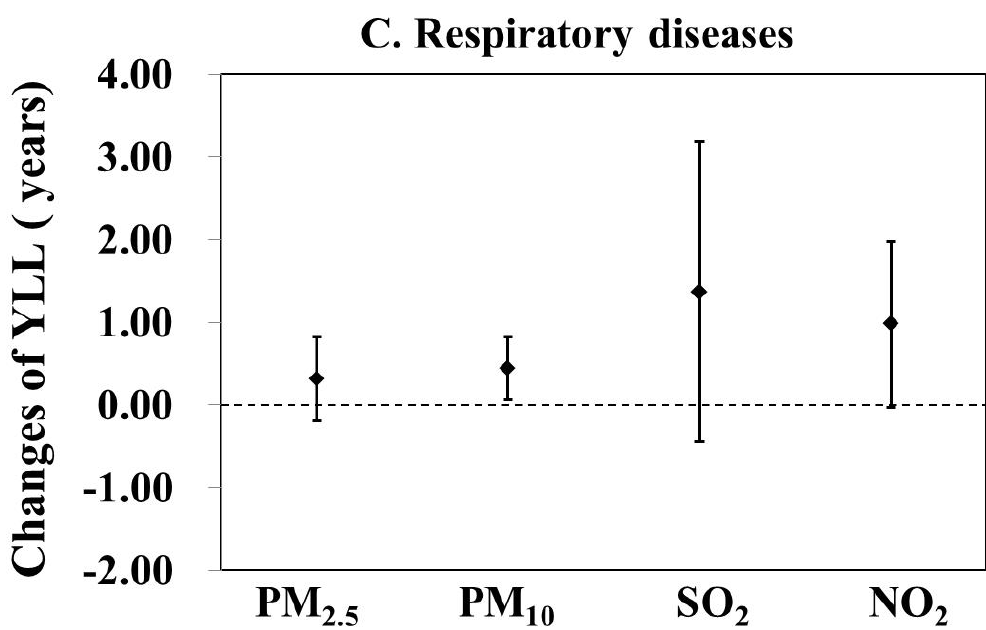
Figure 2. Meta-analysis results for the association between major ambient air pollutants and cause-specific YLL in China. Results are expressed in changes in disease-specific YLL per 10 µ g/m 3 increase in PM 2.5 , PM 10 , SO 2 and NO 2 with 95% confidence intervals. PM 2.5 : particle with aerodynamic diameter ≤ 2.5 µ m; PM 10 : particle with aerodynamic diameter ≤ 2.5 µ m; SO 2 : sulfur dioxide; NO 2 : nitrogen dioxide. ( A ) Non-accidental diseases, NPM 2.5 = 3, NPM 10 = 8, NSO 2 = 6, NNO 2 = 6. ( B ). cardiovascular diseases, NPM 2.5 = 3, NPM 10 = 5, NSO 2 = 3, NNO 2 = 2. ( C ). respiratory diseases, NPM 2.5 = 2, NPM 10 = 5, NSO 2 = 3, NNO 2 = 2. Table 1. Meta-analysis results for the association between ambient air pollutants and YLL to other diseases in China. Air Pollutants No. of